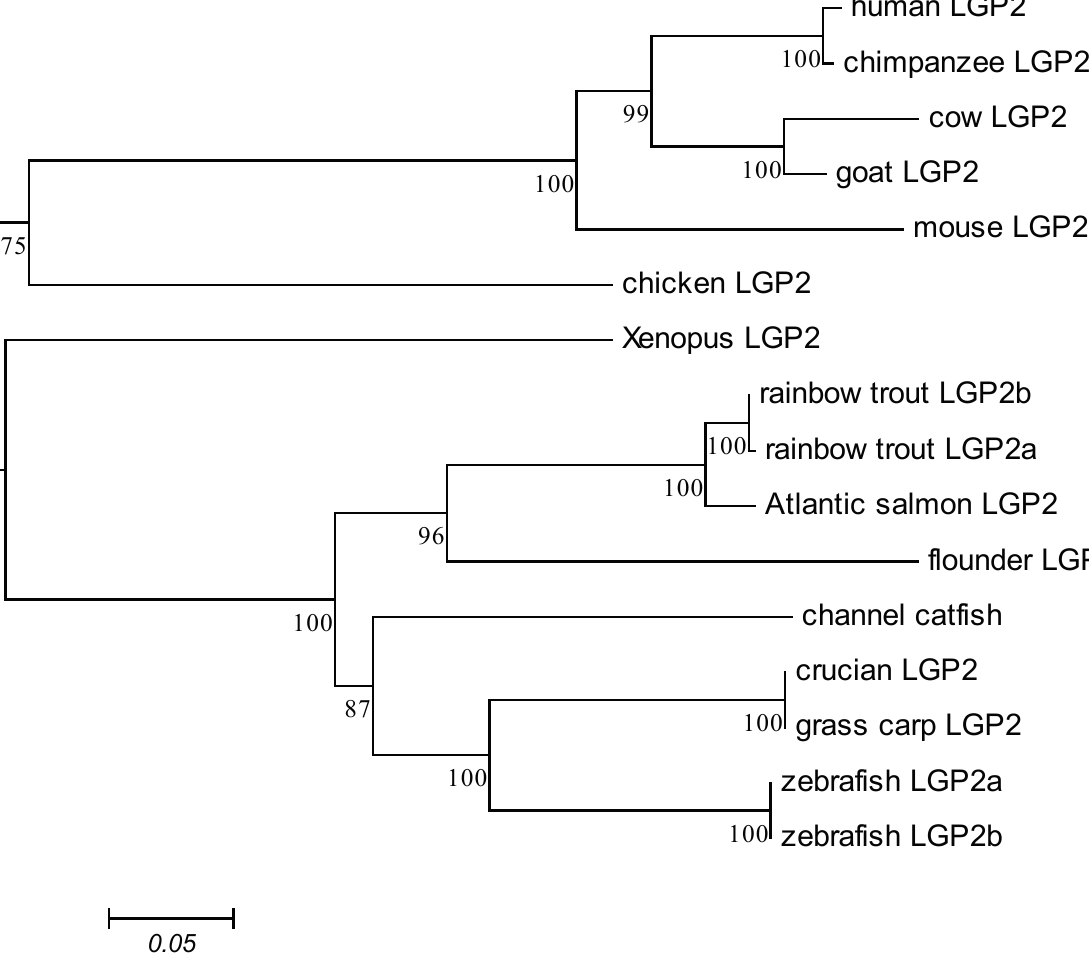
Figure 1. Phylogenetic tree of the laboratory of genetics and physiology 2 (LGP2) from zebrafish and other species. The protein sequences used for phylogenetic analysis were Atlantic salmon LGP2 ( Salmo salar , ACI33640.1), channel catfish ( Ictalurus punctatus , AFS34610.1), ( Pan troglodytes , JAA34322.1), cow LGP2 ( Bos taurus , AAI46129.1), crucian LGP2 (Carassius auratus, AEN04474.1), flounder LGP2 ( Paralichthys olivaceus , ADM18136.1), goat LGP2 ( Capra hircus , XP_005693898.1), grass carp LGP2 ( Ctenopharyngodon idella , AFQ93565.1), human LGP2 ( Homo sapiens , NM_024119.2), mouse LGP2 ( Mus musculus ,